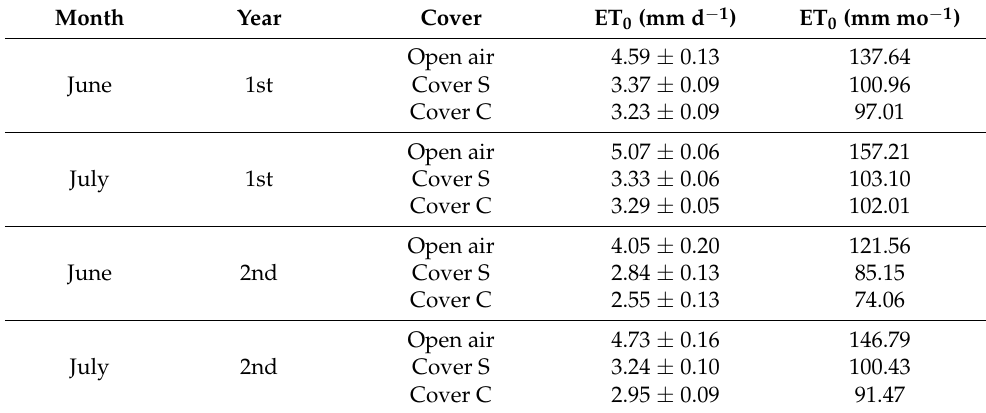
Figure 7. Course of average daily reference evapotranspiration (ET 0 ) estimated in June and July of the first ( a ) and the second ( b ) year of trial, in open field and under plastic covers C (Coverlys ® agrotextile) and S (Serrosol film). Table 3. Average data of daily and monthly ET 0 estimated in open air and under plastic covers C (Coverlys ® agrotextile) and S (Serrosol film) in the two years of trial.